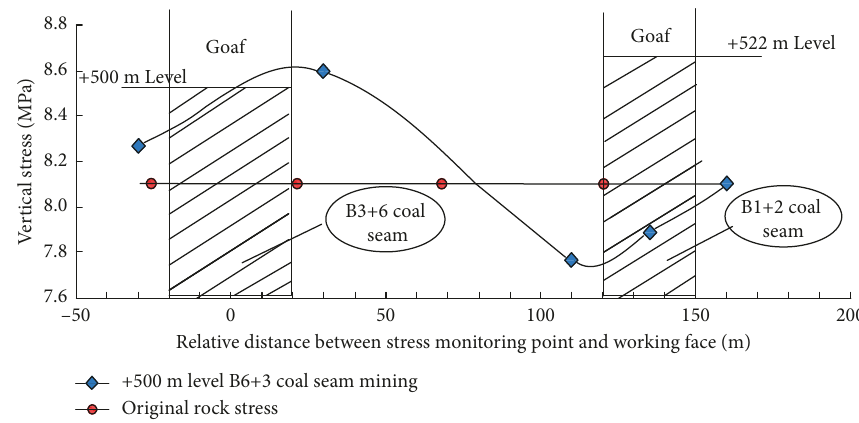
Figure 4: Profile of stress distribution law of stress monitoring points of +500 m horizontal working face.